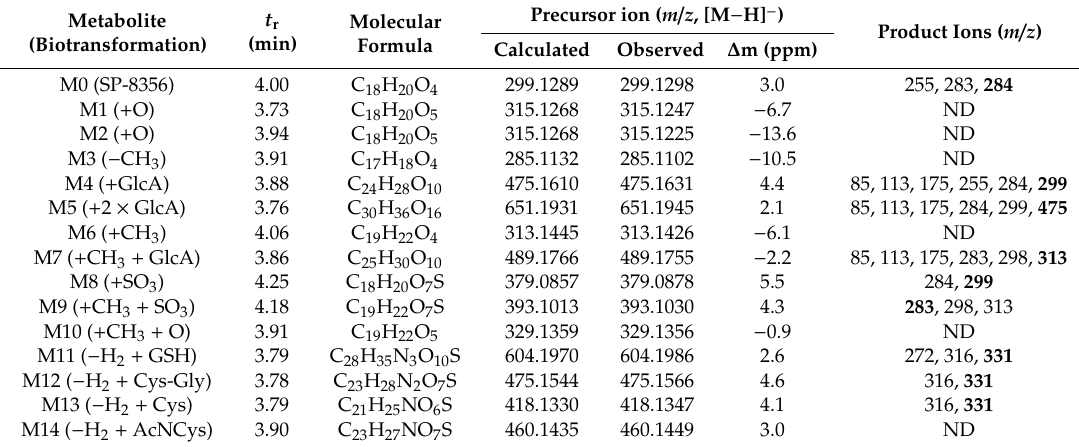
Table 2. Mass spectral data of SP-8356 and its putative metabolites identified in rat and dog plasma. Metabolite